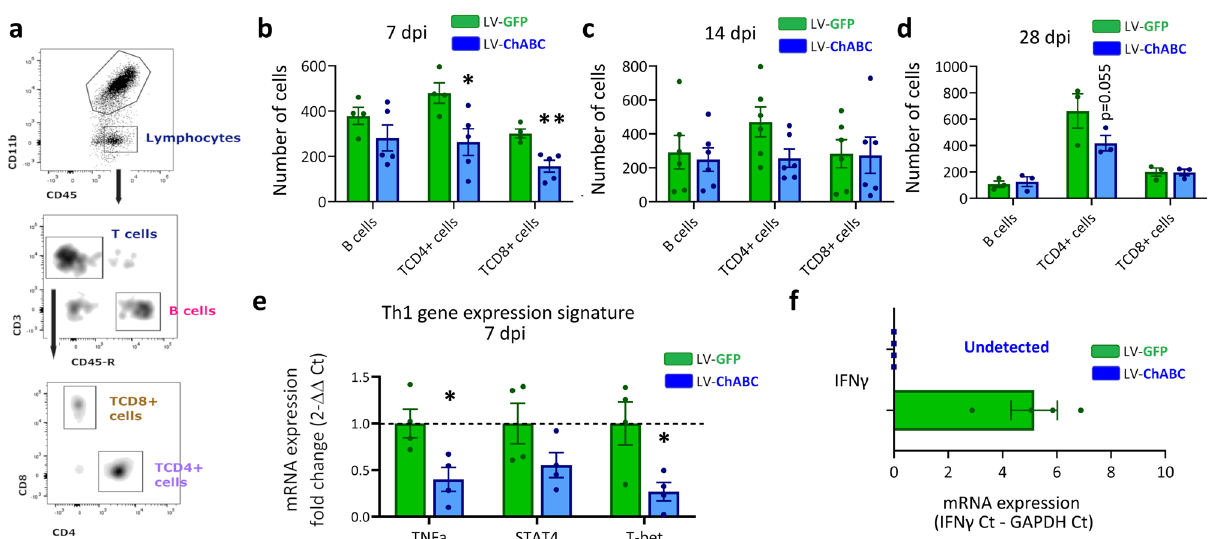
Fig. 5 CSPG digestion reduces T cell in fi ltration and Th1 signature after spinal cord injury. a Gating strategy used for lymphocyte recruitment assessment. b – d Graphs showing quanti fi cation of lymphocyte recruitment following SCI at b 7, c 14, and d 28 dpi with (LV-ChABC) or without